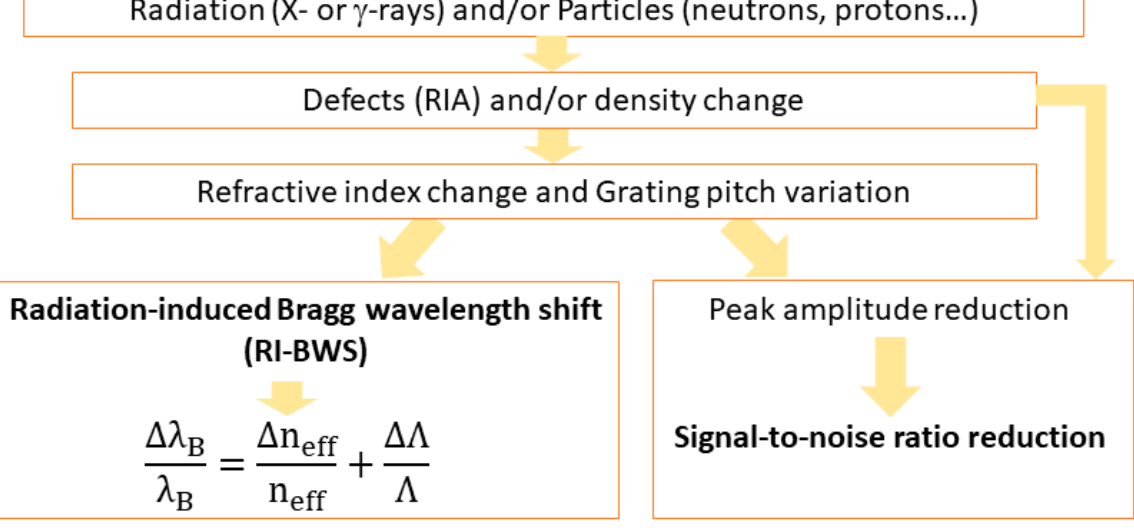
Figure 3. Origins of the radiation effects on the FBG peak: radiation-induced Bragg wavelength shift